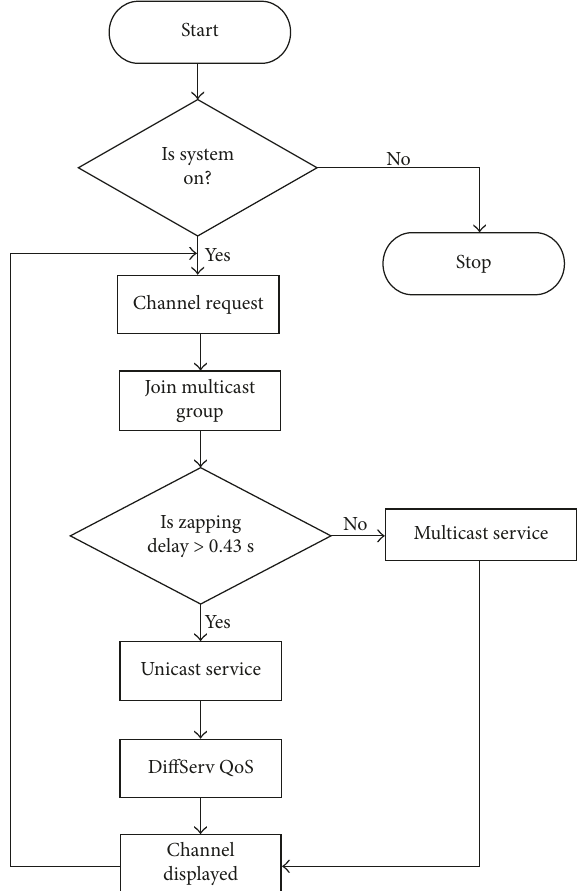
Figure 3: The adaptive hybrid delivery of IPTV